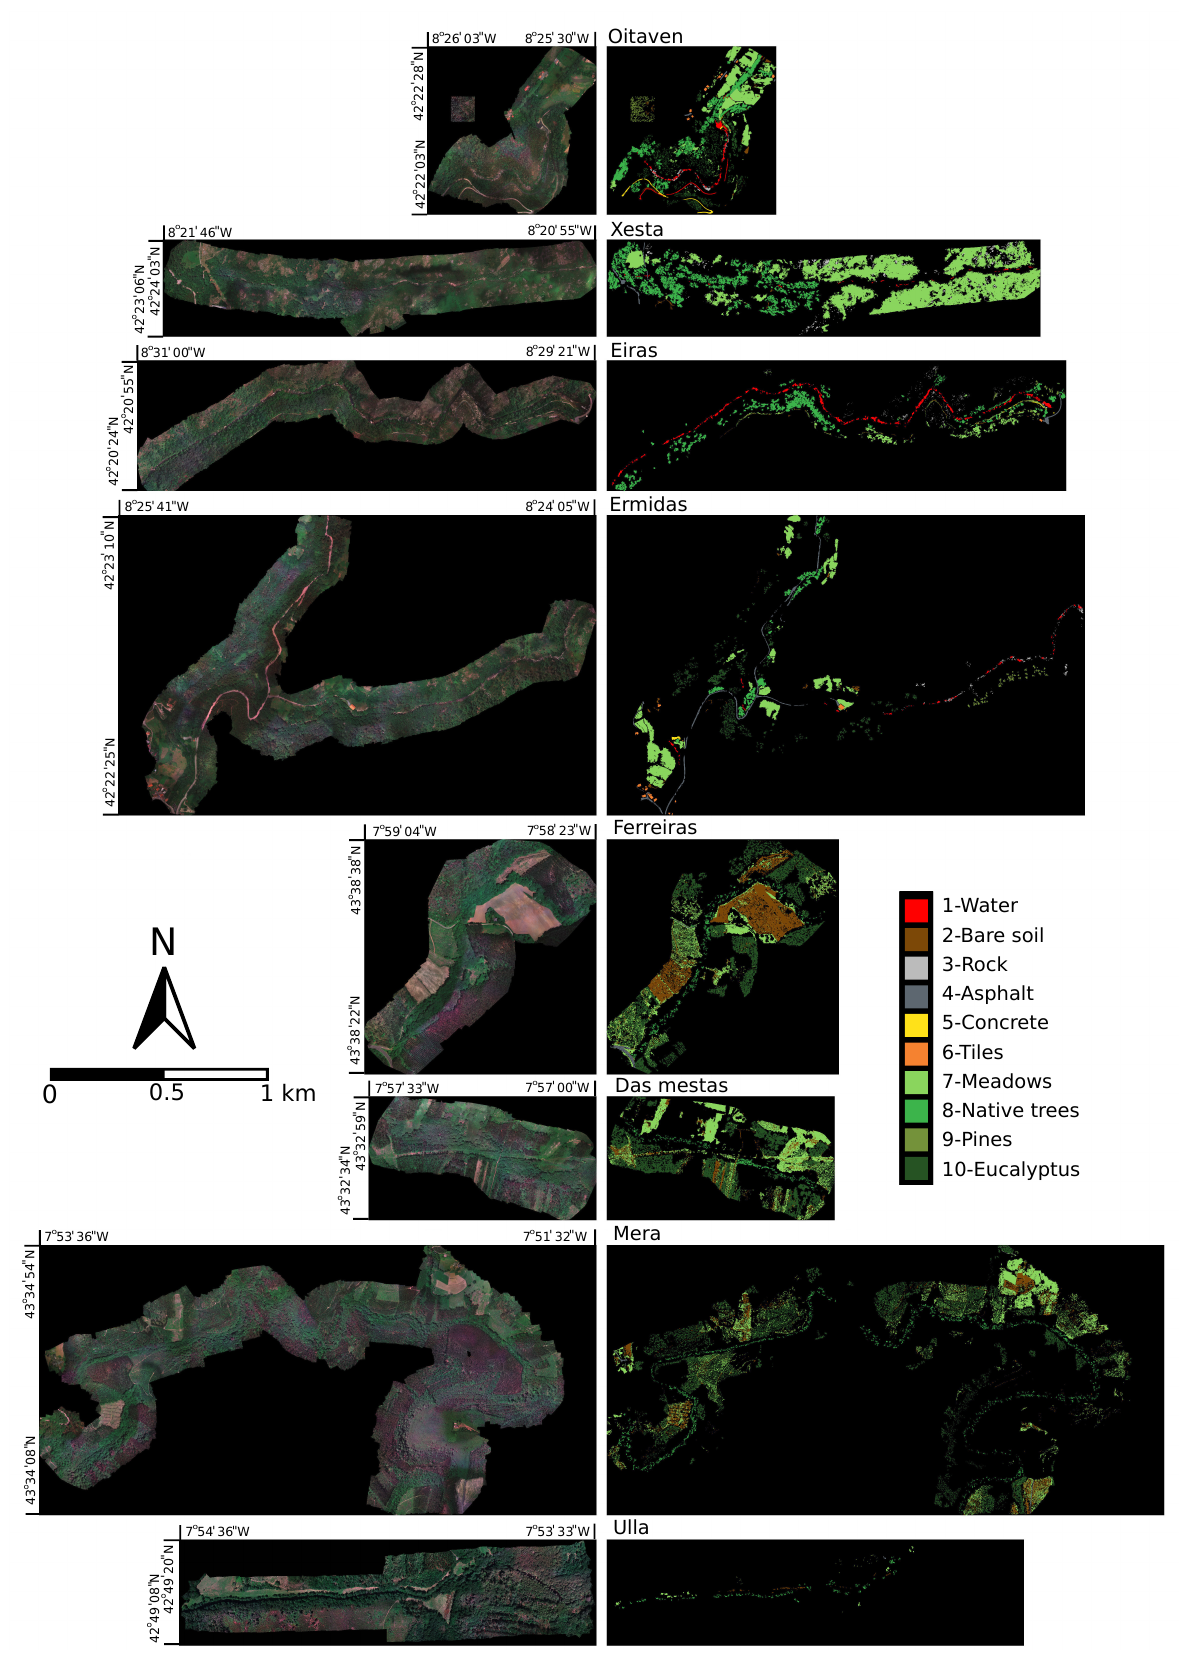
Figure 14. Multispectral datasets (color composite and reference data) used in this study: Oitaven, Xesta, Eiras, Ermidas, Ferreiras, Das Mestas, Mera, and Ulla